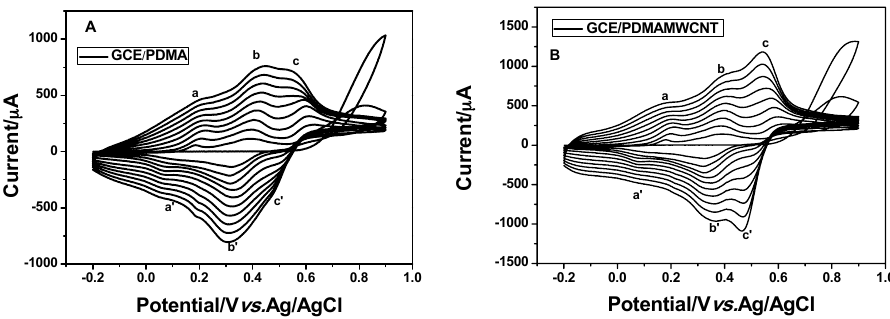
Figure 1. Cyclic voltammograms (CVs) for the electrochemical synthesis of ( A ) poly(dimethoxyaniline) (PDMA) and ( B ) poly(dimethoxyaniline)-multi-walled carbon nanotube (PDMA-MWCNT) films on glassy carbon electrode (GCE) in 1.0 M HCl at a scan rate of 50 mV·s − 1